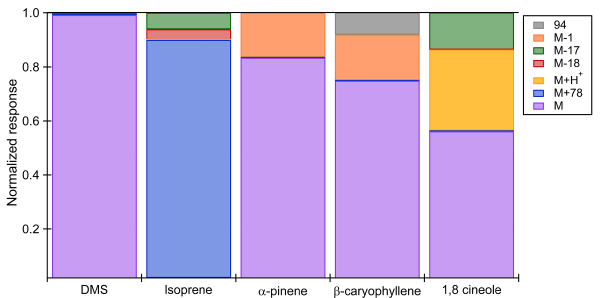
Figure 6. Normalized response of the CI-ToFMS to a series of VOC standards. Significant products (>5% of instrument response) are shown for DMS, isoprene, α -pinene, β -caryophyllene, and euca- lyptol (1,8-cineole). For eucalyptol, the ratio of charge transfer to proton transfer products was roughly 2 : 1. Expected contributions from carbon-13 isotopes were accounted for in the calculated proton transfer